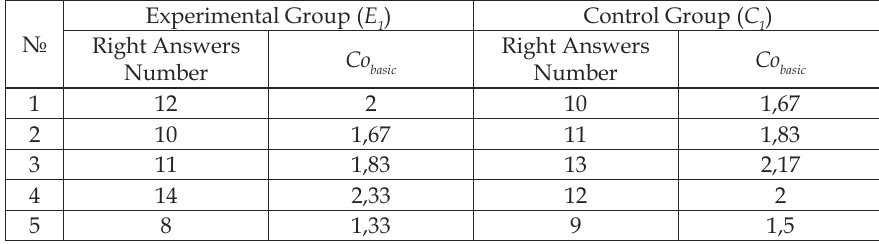
Table 1. E and C pre-experimental testing Wilcoxon, and Mann-Whitney U-tests 1 1 estimation